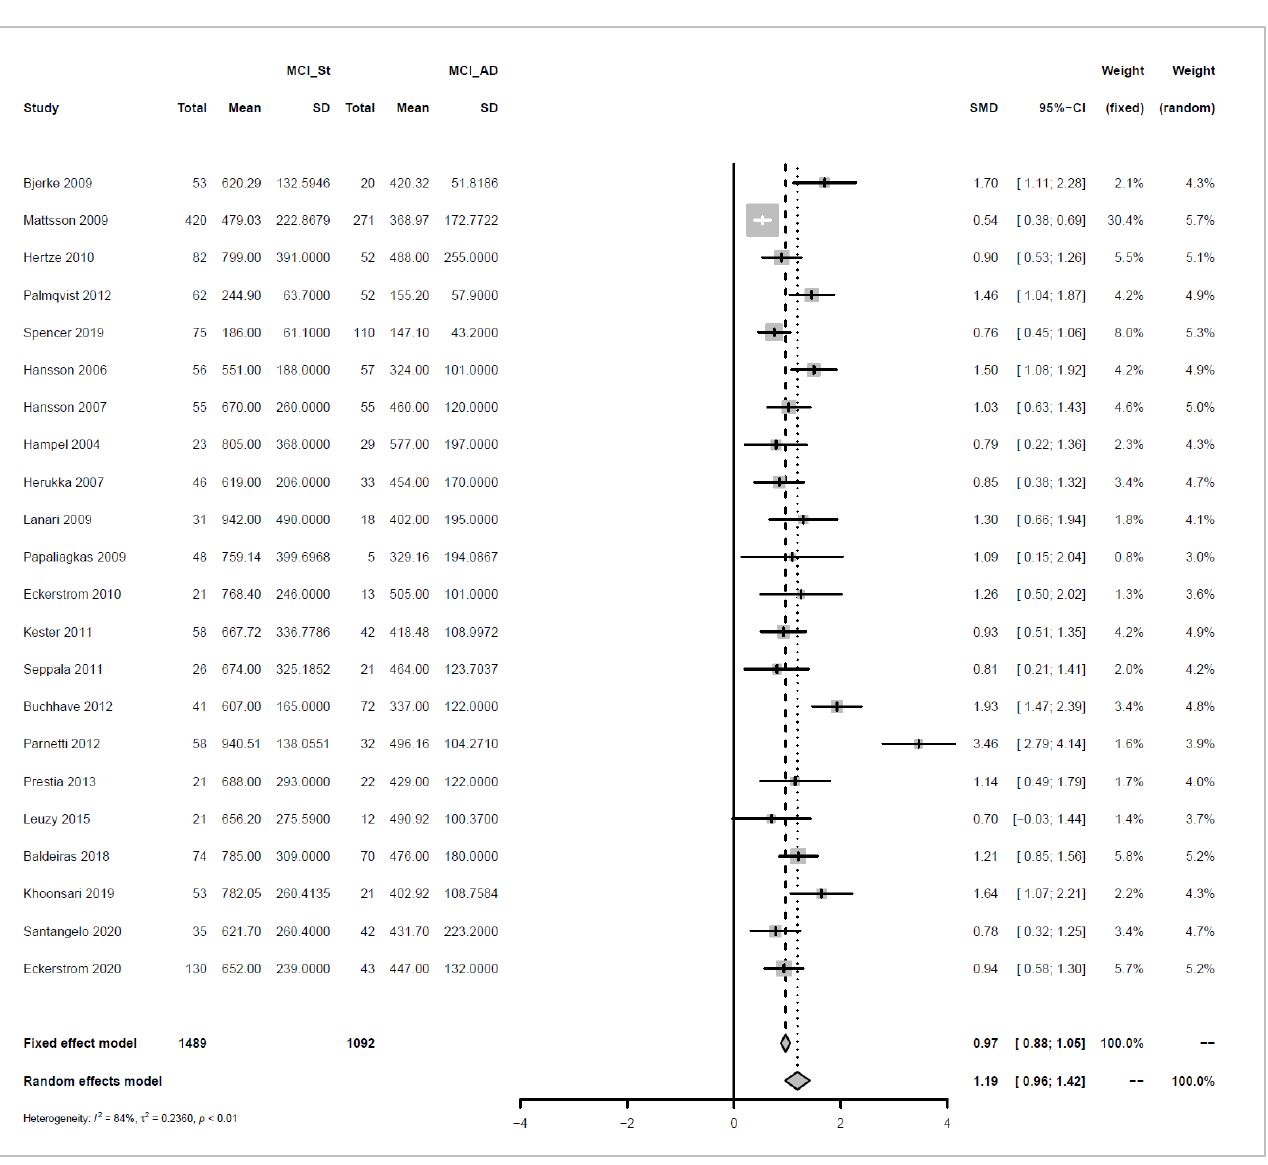
Figure 7. Meta- analysis of studies investigating CSF Aβ1 -42 levels for non-progressive MCI Figure 7. Meta-analysis of studies investigating CSF A β 1-42 levels for non-progressive MCI (MCI_St) (MCI_St) versus progressive MCI (MCI_AD), see Appendix A.2.1 [30,32 – 37,44 – 58] . versus progressive MCI (MCI_AD), see Appendix A.2.1